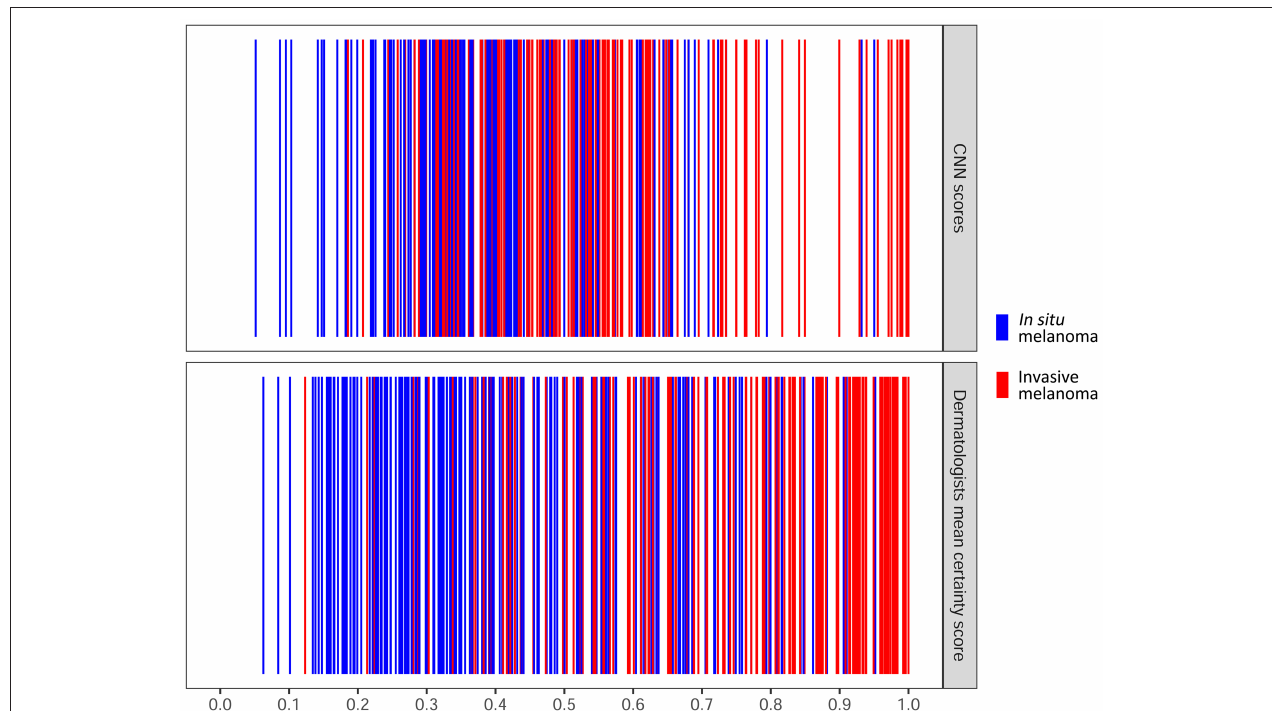
FIGURE 4 | Distribution map of dermatologists and CNN output of all cases. Each individual line represents one case. Higher scores indicated that dermatologists and the CNN considered the lesion to be invasive with a higher degree of certainty. The x-axis for the dermatologists represents the mean of certainty scores of all the seven dermatologists ranging from 0 to 1. The x-axis for the CNN represents the output score of CNN ranging from 0 to 1. CNN, convolutional neural